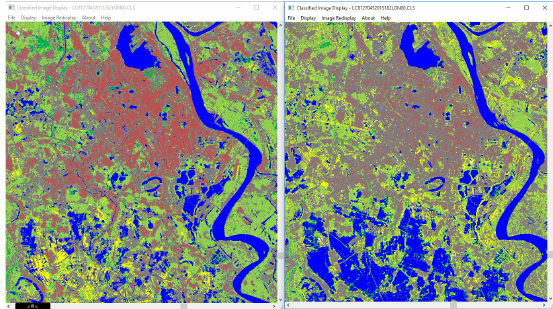
Figure 6. Comparison of automated classification results of scenes LC81270452013352LGN00 (left) and LC81270452015182LGN00